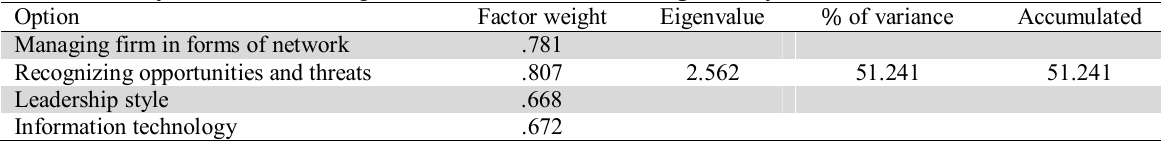
Option Factor weight Eigenvalue % of variance Accumulated Managing firm in forms of network .781